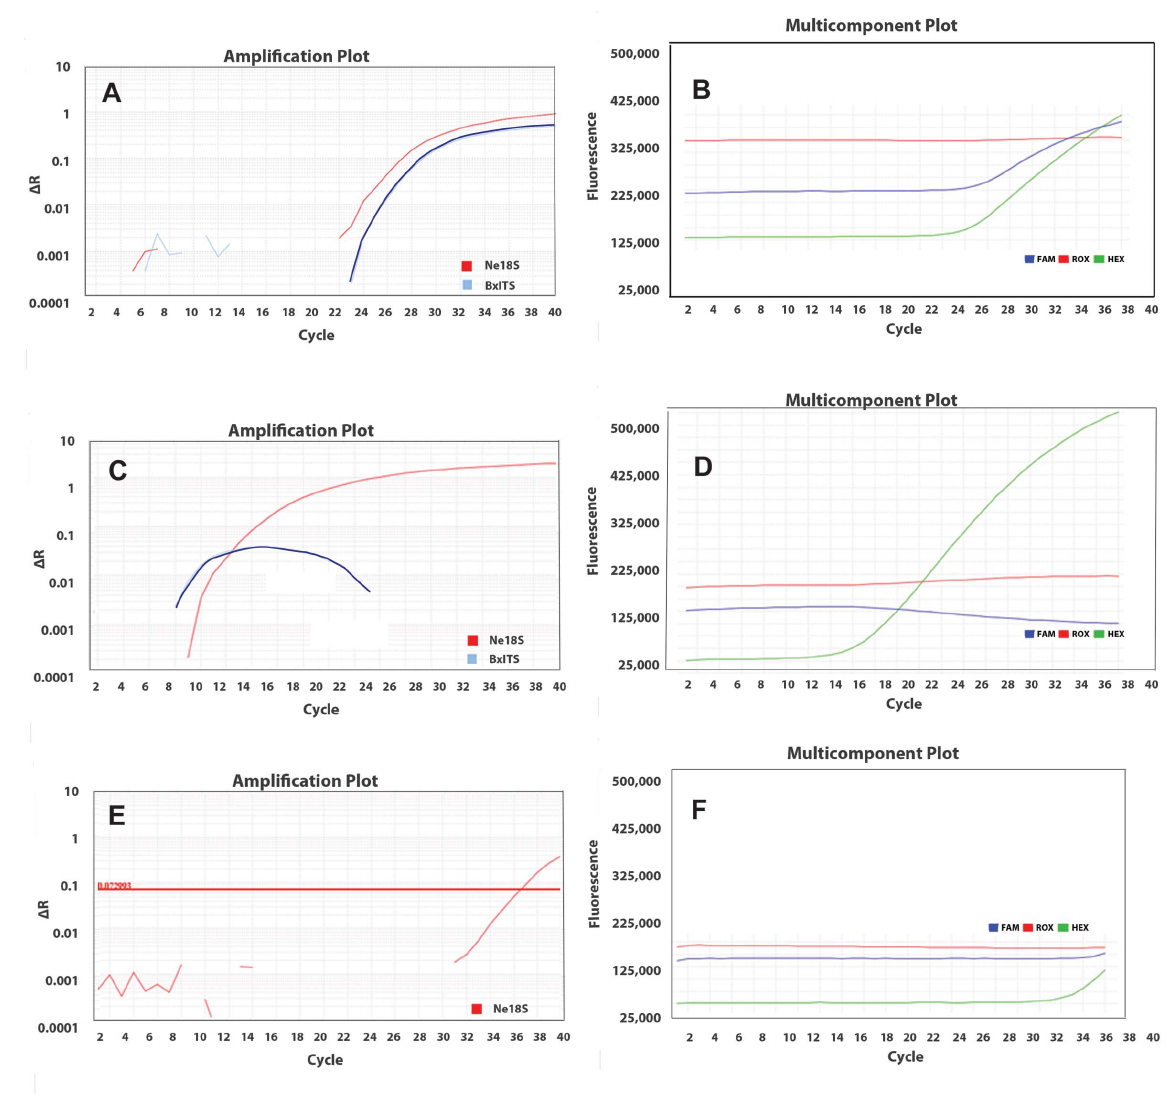
Figure 7. Duplex real-time-PCR result. A. A positive result with two sigmoid FAM and HEX curves in amplification plot. B. A positive result with two sigmoid FAM and HEX curves and non-increased ROX in multi-component plot. C. A negative result with one sigmoid HEX curve, and non- increased FAM curve and non-increased ROX in amplification plot. D. A negative result with one sigmoid HEX curve, and non-increased FAM curve and non-increased ROX in multi-component plot. E. A false-positive result with a slightly later-increased HEX curve (C t . 35) in amplification plot. F. A false-positive result with a slightly later-increased HEX curve (C t . 35) and non-increased FAM and ROX curves in multi-component plot.